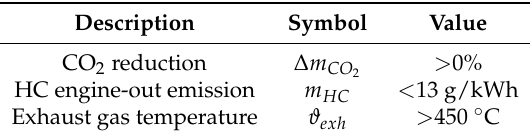
Table 1. Low-Load